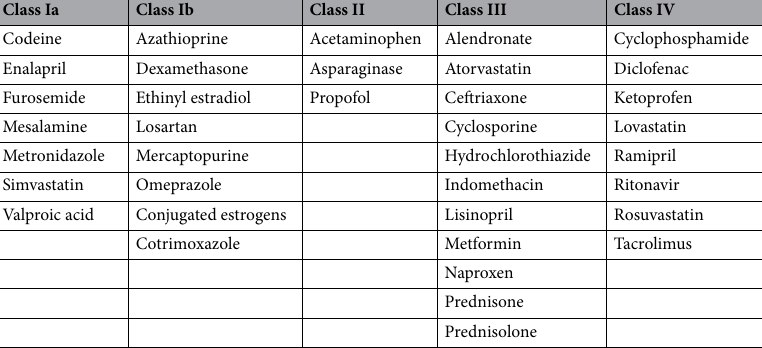
Table 2. Concomitant drugs with potential to cause pancreatitis received by patients with tocilizumab- associated pancreatic adverse events 20 . The drugs have been listed in a particular class based on the classification of drugs causing acute pancreatitis suggested by Badalov et al. 20 , which is based on the level of evidence